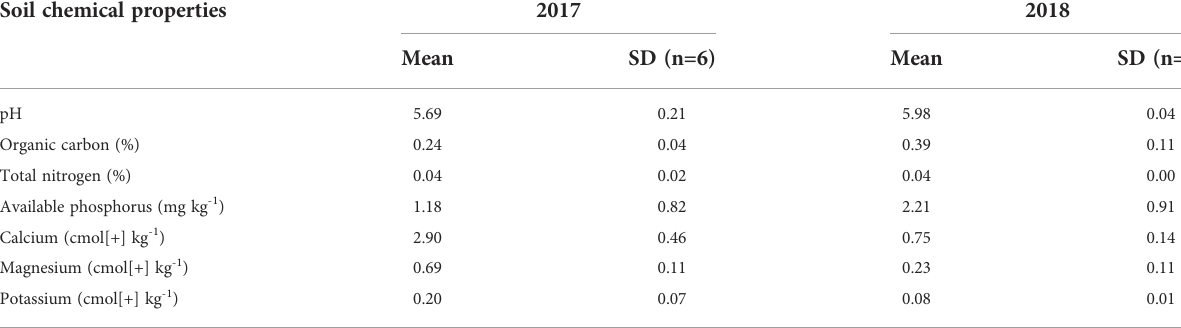
TABLE 2 Soil chemical properties of the experimental site at IITA Ibadan, Nigeria. Soil chemical properties